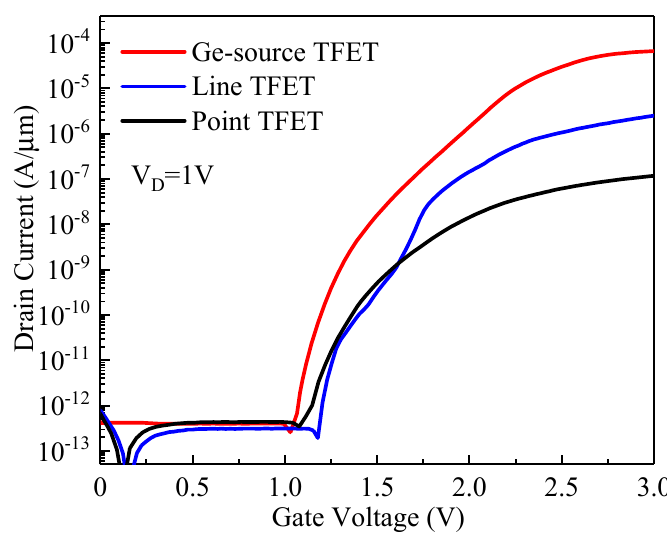
Figure 3. Transfer curves of different TFETs.